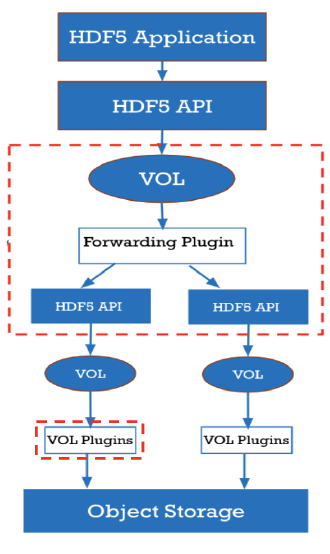
Figure 2. HDF5 VOL Prototype